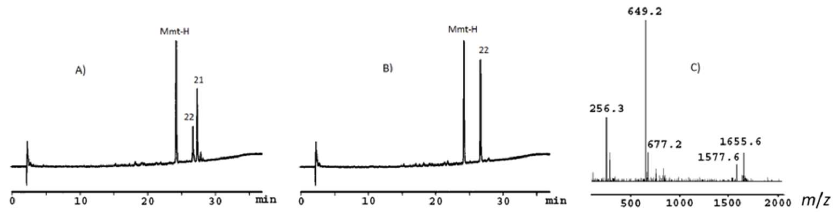
Figure 4. LC-MS analysis of the oxidation of crude hybrid 21 in DMSO, after 12 h ( A ) and 48 h ( B ). Column: Nucleosil C8, 7 µ m, 125 × 4 mm; flow rate: 1 mL / min; gradient: from 50 to 100% acetonitrile in water within 30 min; detection at 265 nm. ( C ) ES-MS analysis of the oxidized dimer 22 . [M + Na] + calc: 1655.80; [M + Na] + found: 1655.6.